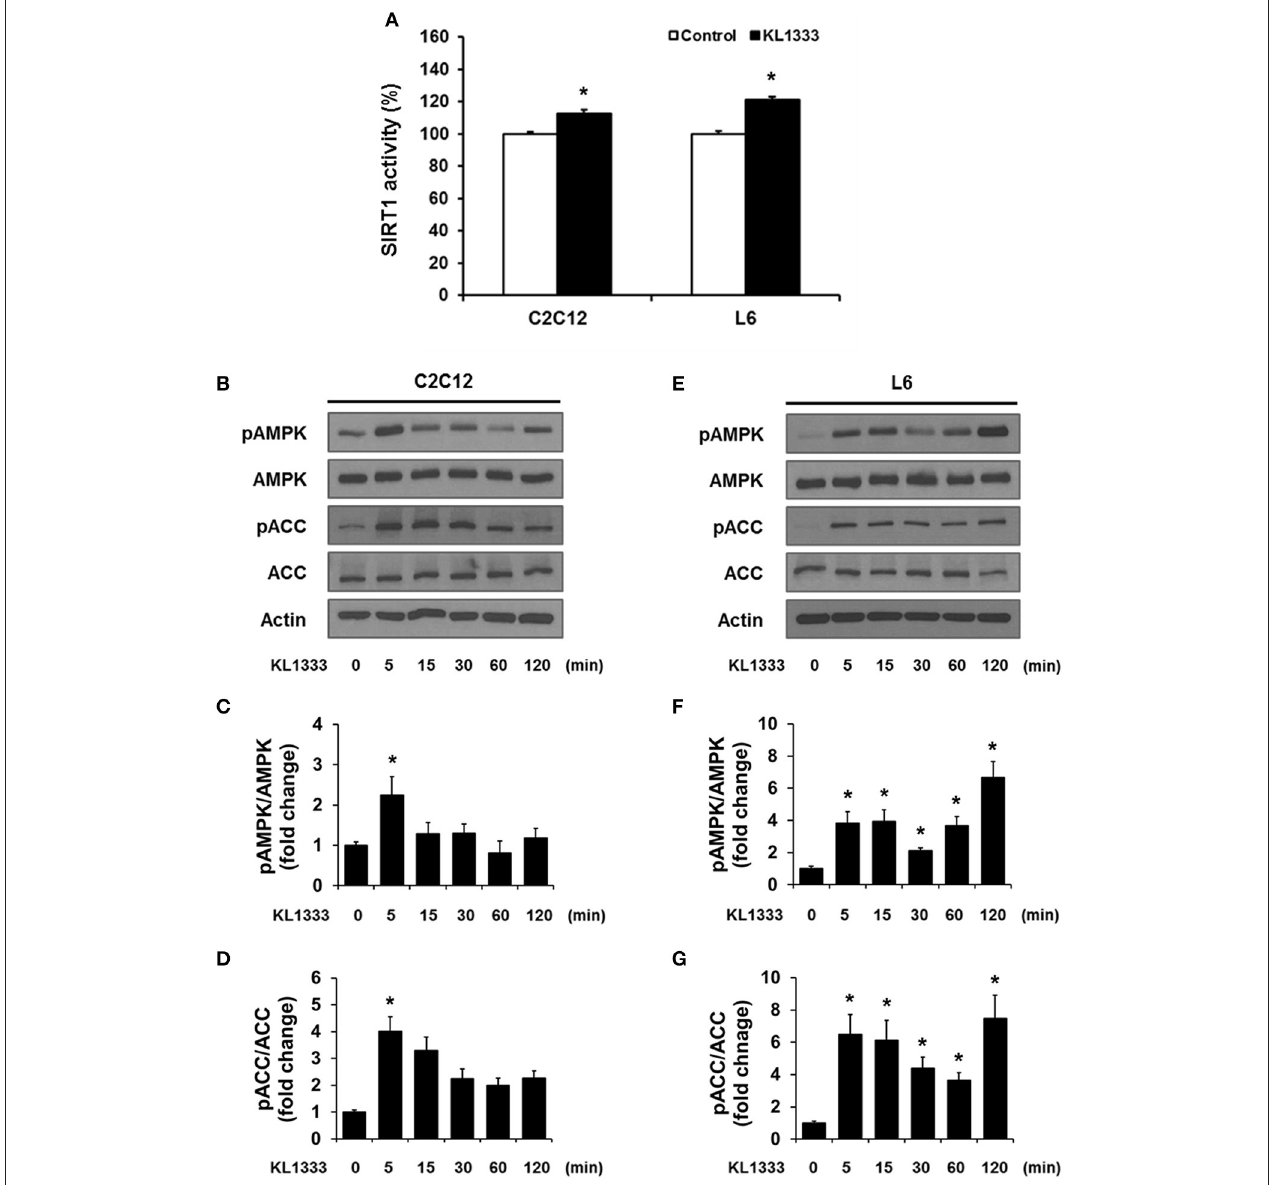
FIGURE 2 | KL1333 activates SIRT1 and AMPK. (A) C2C12 and L6 myoblasts were treated with 1 and 2 µ M KL1333 for 1h, respectively. SIRT1 activities in both cell lines were analyzed using a fluorescence-based assay. (B) C2C12 myoblasts were treated with 1 µ M KL1333 for the indicated times. The activity of AMPK was examined by Western blotting using the indicated antibodies. (C) Quantification of pAMPK levels in C2C12 cell lysates using its band density normalized to that of total AMPK. (D) Quantification of pACC levels in C2C12 cell lysates using its band density normalized to that of total ACC. (E) L6 myoblasts were treated with 2 µ M KL1333 for the indicated times. The activity of AMPK was examined by Western blotting using the indicated antibodies. (F) Quantification of pAMPK levels in L6 cell lysates using its band density normalized to that of total AMPK. (G) Quantification of pACC levels in L6 cell lysates using its band density normalized to that of total ACC. Each experiment was repeated three times. Error bars indicate ± SEM. * P < 0.05.